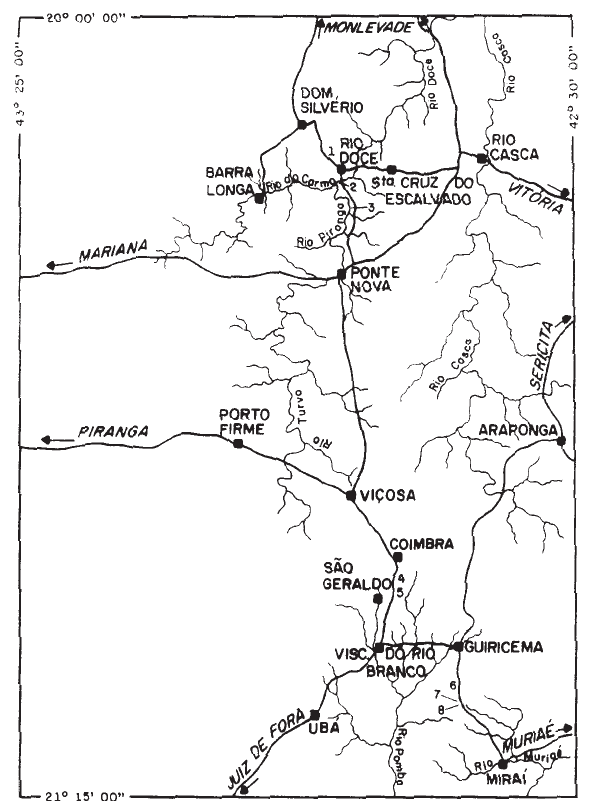
Figura 1. Localização aproximada dos perfis